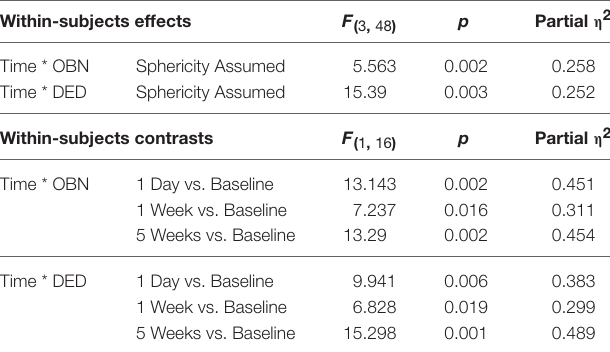
TABLE 1 | Repeated measures ANOVA; OBN and DED predict changes in QIDS-SR over different time points up to 5 weeks. Within-subjects